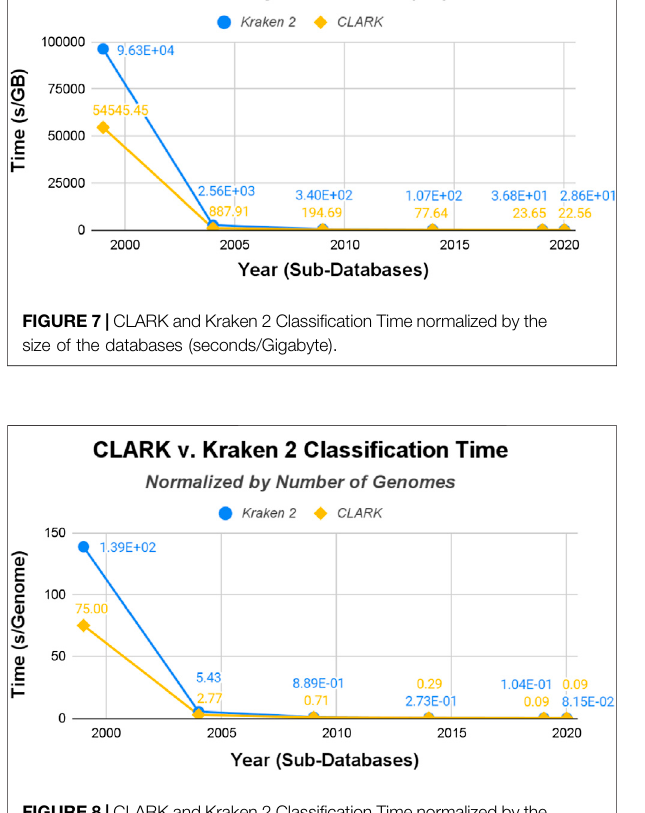
FIGURE 8 | CLARK and Kraken 2 Classi fi cation Time normalized by the number of genomes in the databases (seconds/genome).